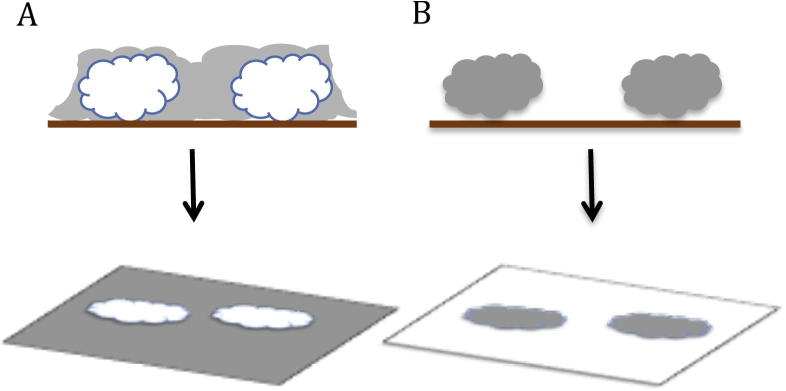
Positive and negative staining using heavy metal salts. In negative staining (A) the stain fully envelops the macromolecular complex; in the micrograph the complex appears white on a dark background. Positive staining (B) results in a small amount of stain forming a thin shell around the molecule, meaning the sample appears dark against a light background.